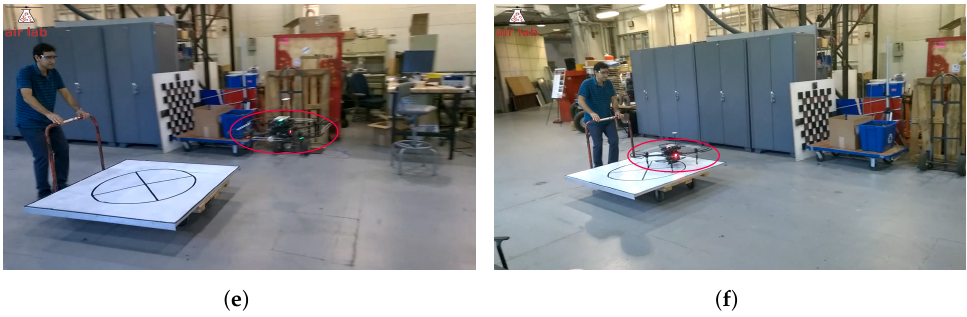
Figure 7. ( a – f ) Screenshots from a video sequence showing our quadrotor landing on a moving platform. In this experiment, the quadrotor is additionally equipped with a DJI Guidance sensor for safe operation in the indoor environment.